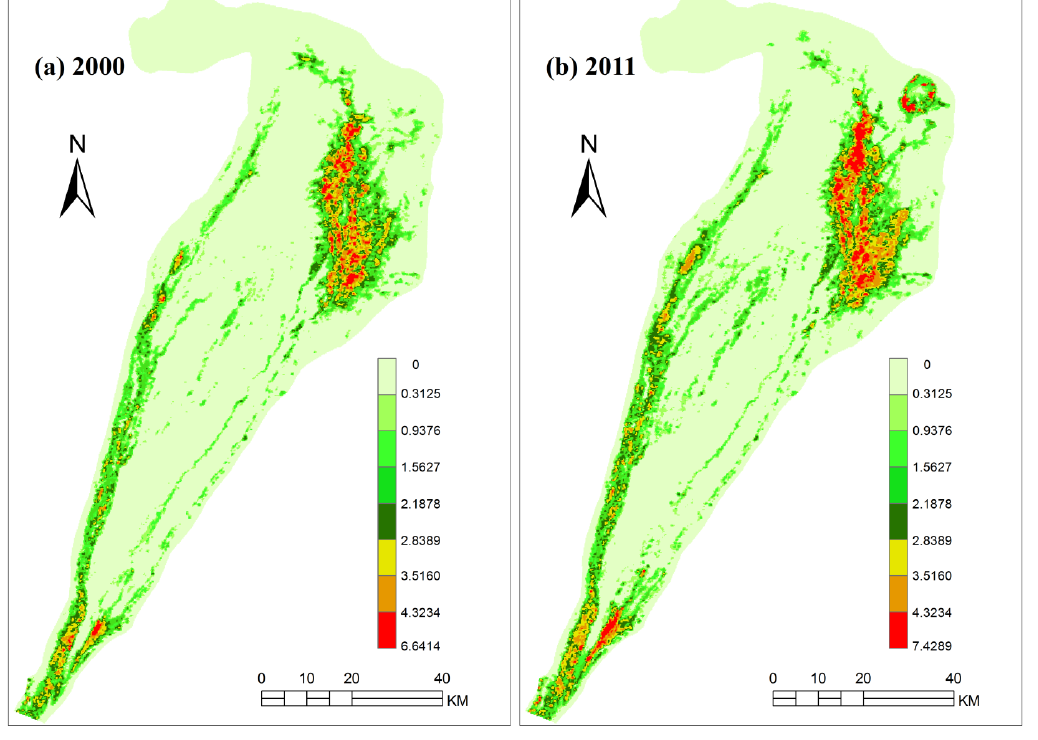
Figure 5. SINDVI maps in 2000 and